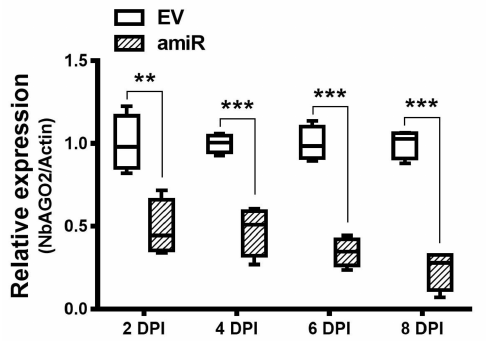
Figure 2. Silencing of NbAGO2 via transient expression of amiR2 from PBI121-based vector. pBI121-amiR2 construct was transformed into GV3101, infiltrated on N. benthamiana leaves, and the leaves were collected at di ff erent DPI. NbAGO2 expression was determined by quantitative real-time PCR. Plants inoculated with empty pBI121 vector (EV) served as control treatment. NbAGO2 expression in control was arbitrarily designated as 1. NbActin gene served as the internal control. Significant di ff erences between control and treatment groups were calculated by Student’s t -test. Double and three asterisks indicated significant di ff erence at p < 0.01 and p < 0.001,